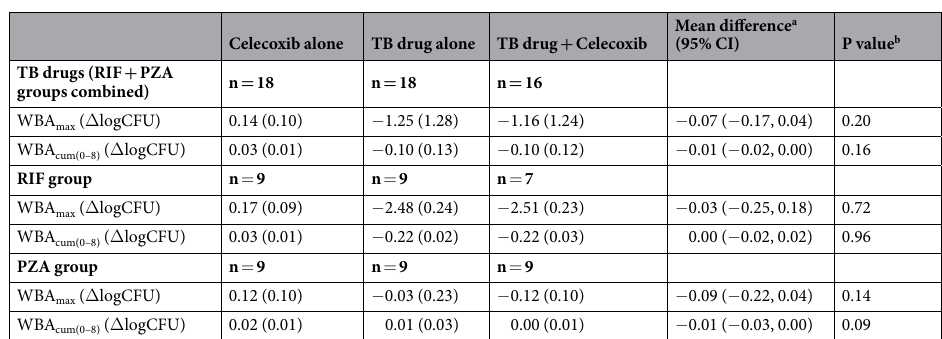
Table 2. Whole-blood bactericidal activity (WBA) results. Values are mean (SD), and mean difference with 95% CI. a Mean difference for TB drug with and without celecoxib is derived from those with paired data for the TB drug i.e. n = 16 for combined groups, n = 7 for RIF group, n = 9 for PZA group. b WBA values were compared between TB drug alone and TB drug plus celecoxib using a paired-sample t-test. P values for WBA max and WBA cum versus zero: 1.00 and 1.00 (Celecoxib alone); < 0.0001 and < 0.0001 (RIF alone); 0.37 and 0.92 (PZA alone). Abbreviations: RIF, rifampicin; PZA, pyrazinamide; CI, confidence